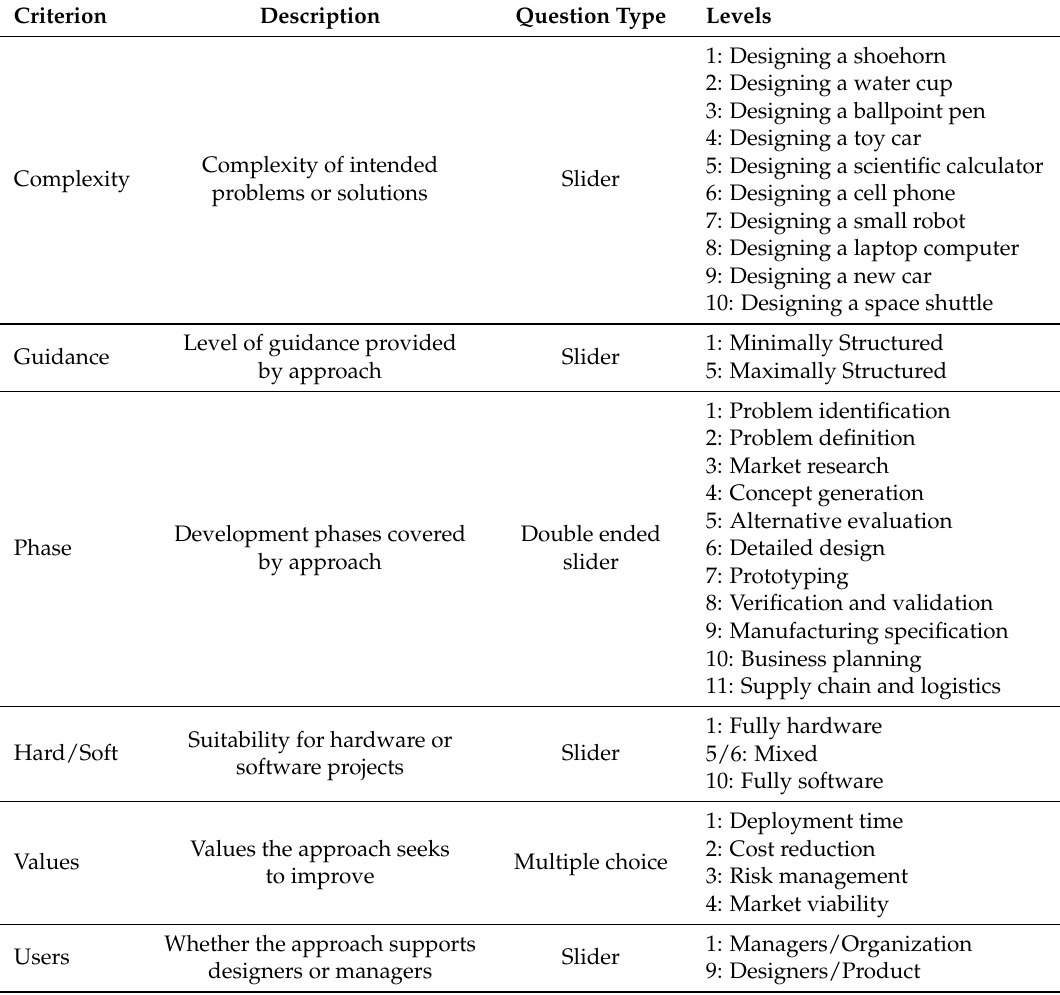
Table 5. Criteria for differentiating design